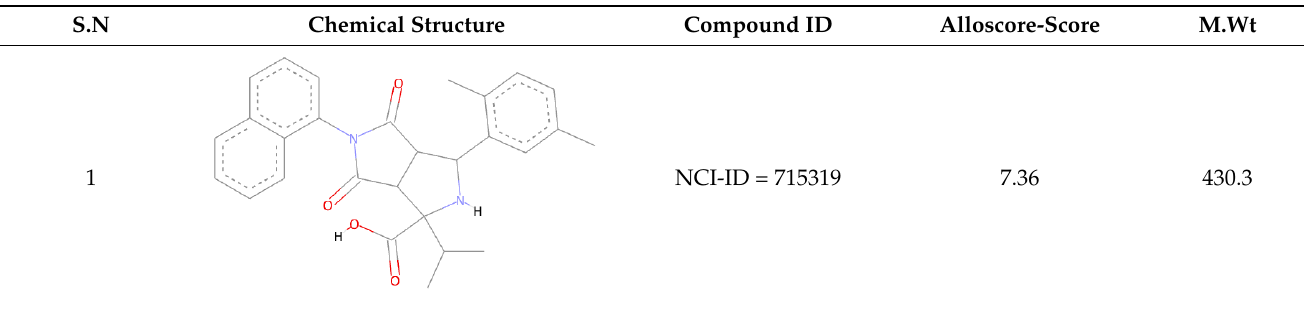
Figure 5. ( A ) Represents the 3- (Upper panel) and 2-dimensional (Lower panel) interactive poses of NCI-ID = 715319, while ( B , C ) are the respective representations of NCI-ID = 718571 and NCI-ID = 715313 with the SARS-CoV-2 MTase Allosteric site, respectively. Table 5. Chemical structures, compound IDs, molecular weights, and alloscore-score rankings from the NCI diversity library.